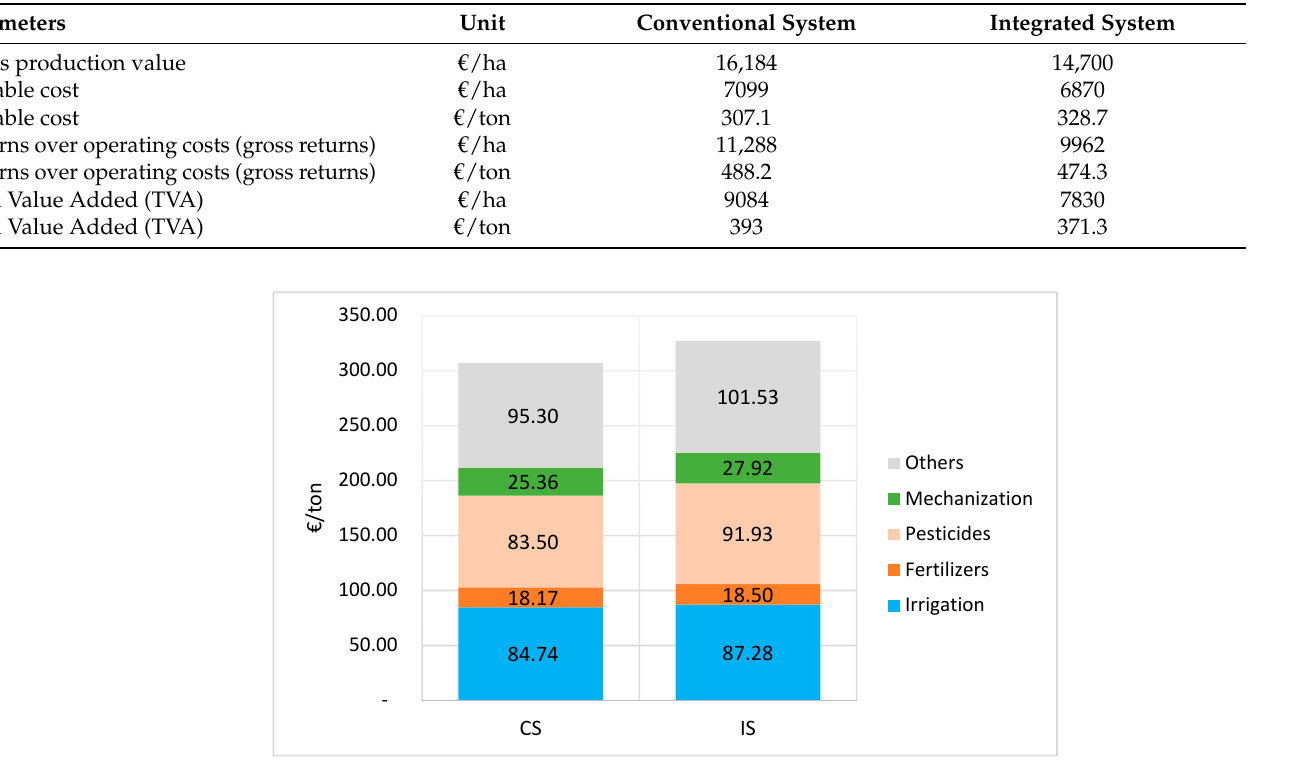
Figure 7. Process production cost for 1 ton of table grape with conventional (CS) and integrated (IS) system.